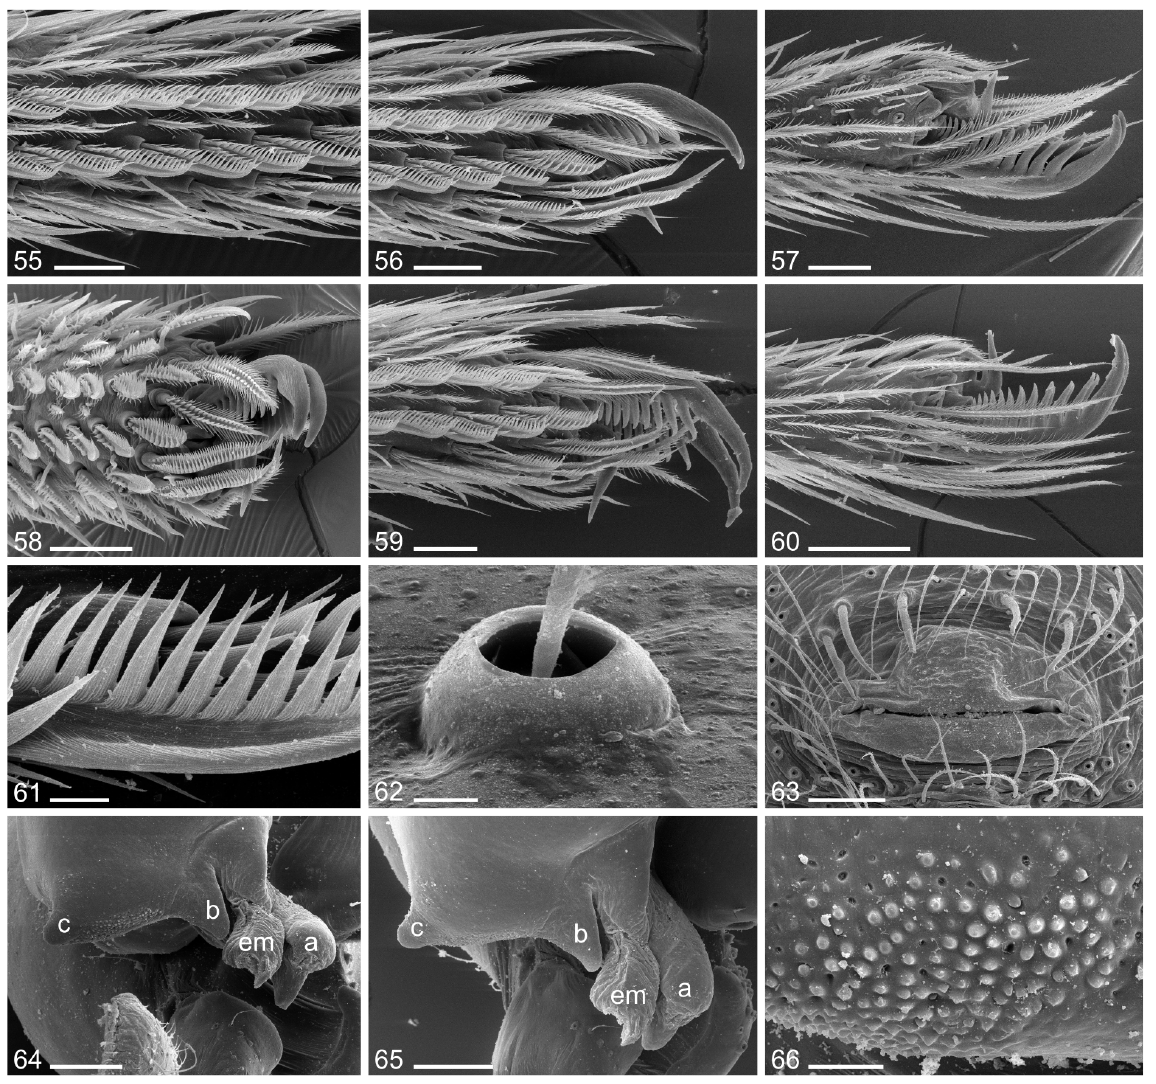
Figs 55–66. Artema nephilit sp. nov., ZFMK Ar 15225-27 (♂) and HUJ Ara 15997 (♀). 55–56 . Comb- hairs on left male tarsus 4, prolateral views. 57 . Right male tarsus 2, showing absence of comb-hairs. 58–59 . Comb-hairs on left female tarsus 4, prolateral (-distal) views. 60 . Right female tarsus 2, showing absence of comb-hairs. 61 . Detail of male comb-hair on tarsus 4. 62 . Trichobothrium base, female palpal tibia. 63 . Male gonopore and epiandrous spigots. 64–65 . Male bulbal processes. 66 . Modified area between processes b and c on male genital bulb. Scale lines: 55, 58 = 0.08 mm; 56–57, 59, 63 = 0.1 mm; 60, 64–65 = 0.2 mm; 61–62 = 0.01 mm; 66 =